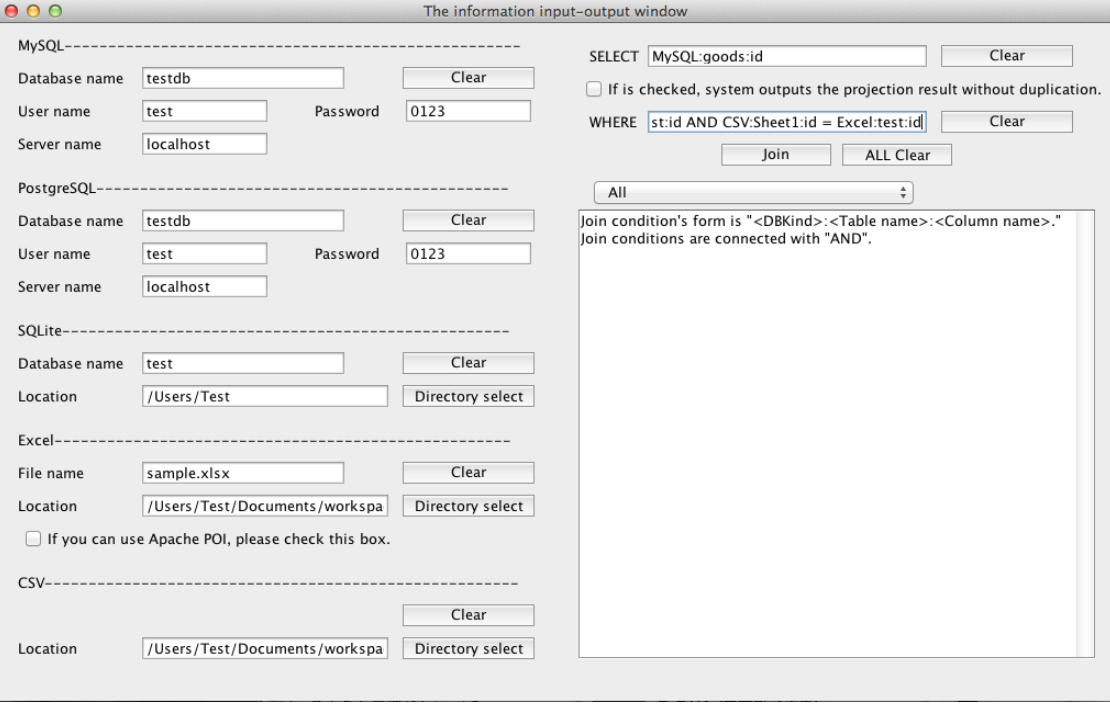
Fig. 5. An example of specification of input information.